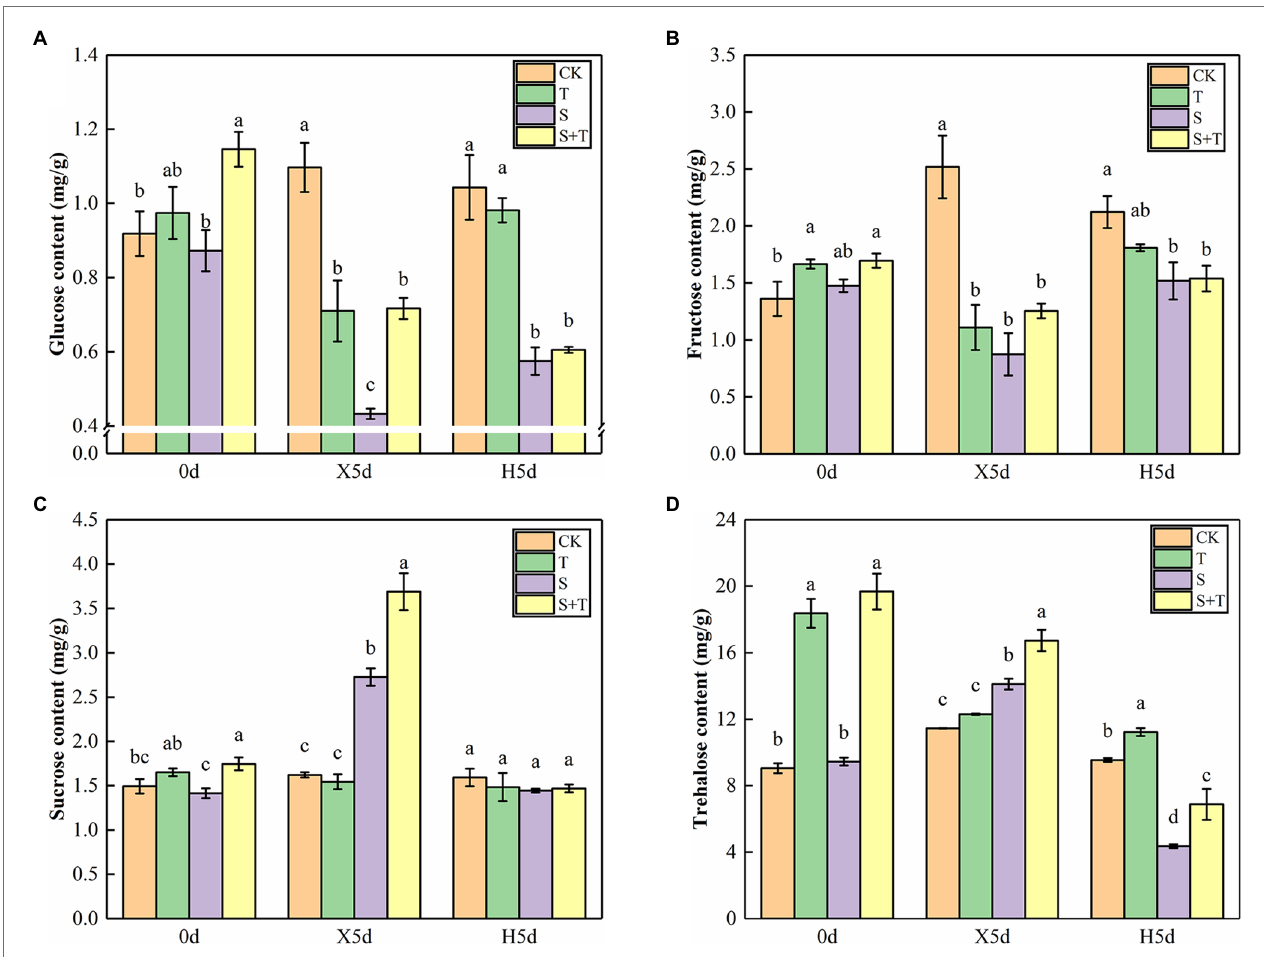
FIGURE 6 | Effects of foliar-applied trehalose on carbohydrate content of tomato leaves under stress and non-stress conditions. (A) Glucose content. (B) Fructose content. (C) Sucrose content. (D) Trehalose content. The results showed the mean ± SE of three replicates, and the different letters denote the significant difference among treatments ( p < 0.05), according to Duncan’s multiple test. CK, control; T, 10 mM trehalose; S, 150 mM NaCl; S + T, 150 mM NaCl +10 mM